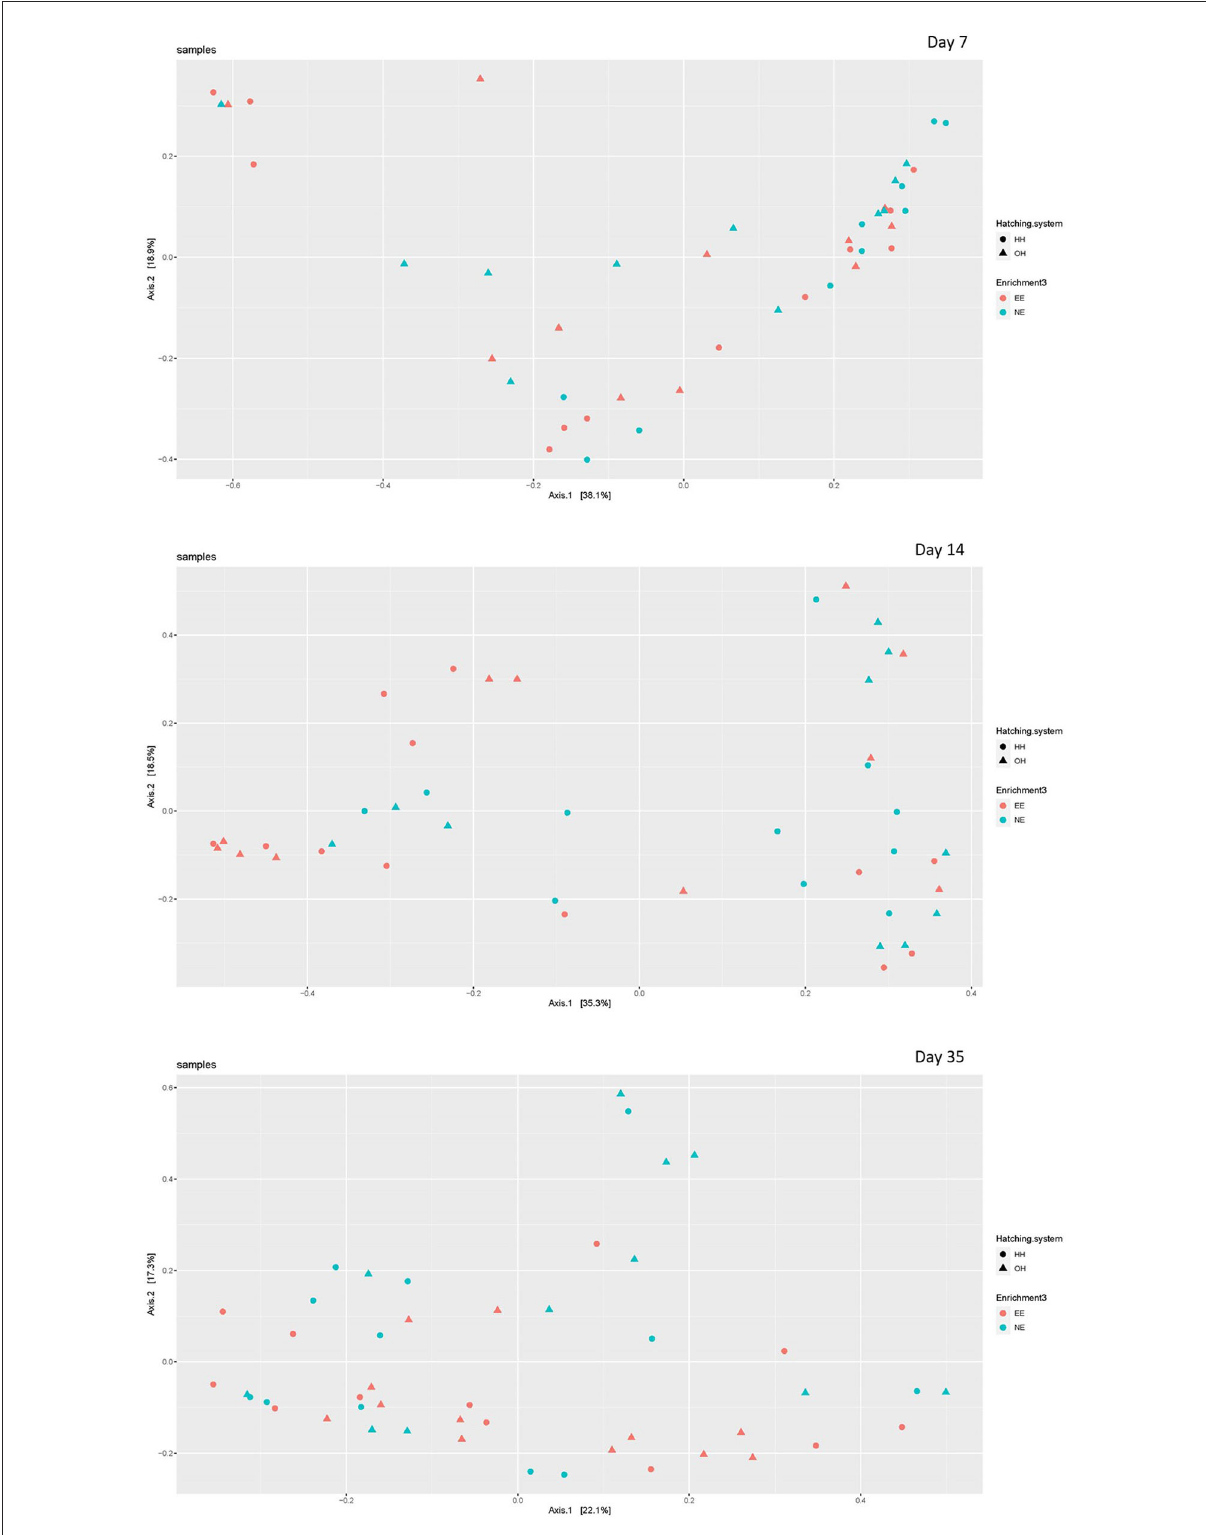
FIGURE5 Principal coordinate analysis (family level) of jejunal microbiota on day 7 (upper plot), day 14 (middle plot), and day 35 (bottom plot) for the different treatments [with a dark brooder (EE) and without a brooder (NE), and hatchery-hatched (HH) respectively, on-farm hatched (OH)]. Each point represents a